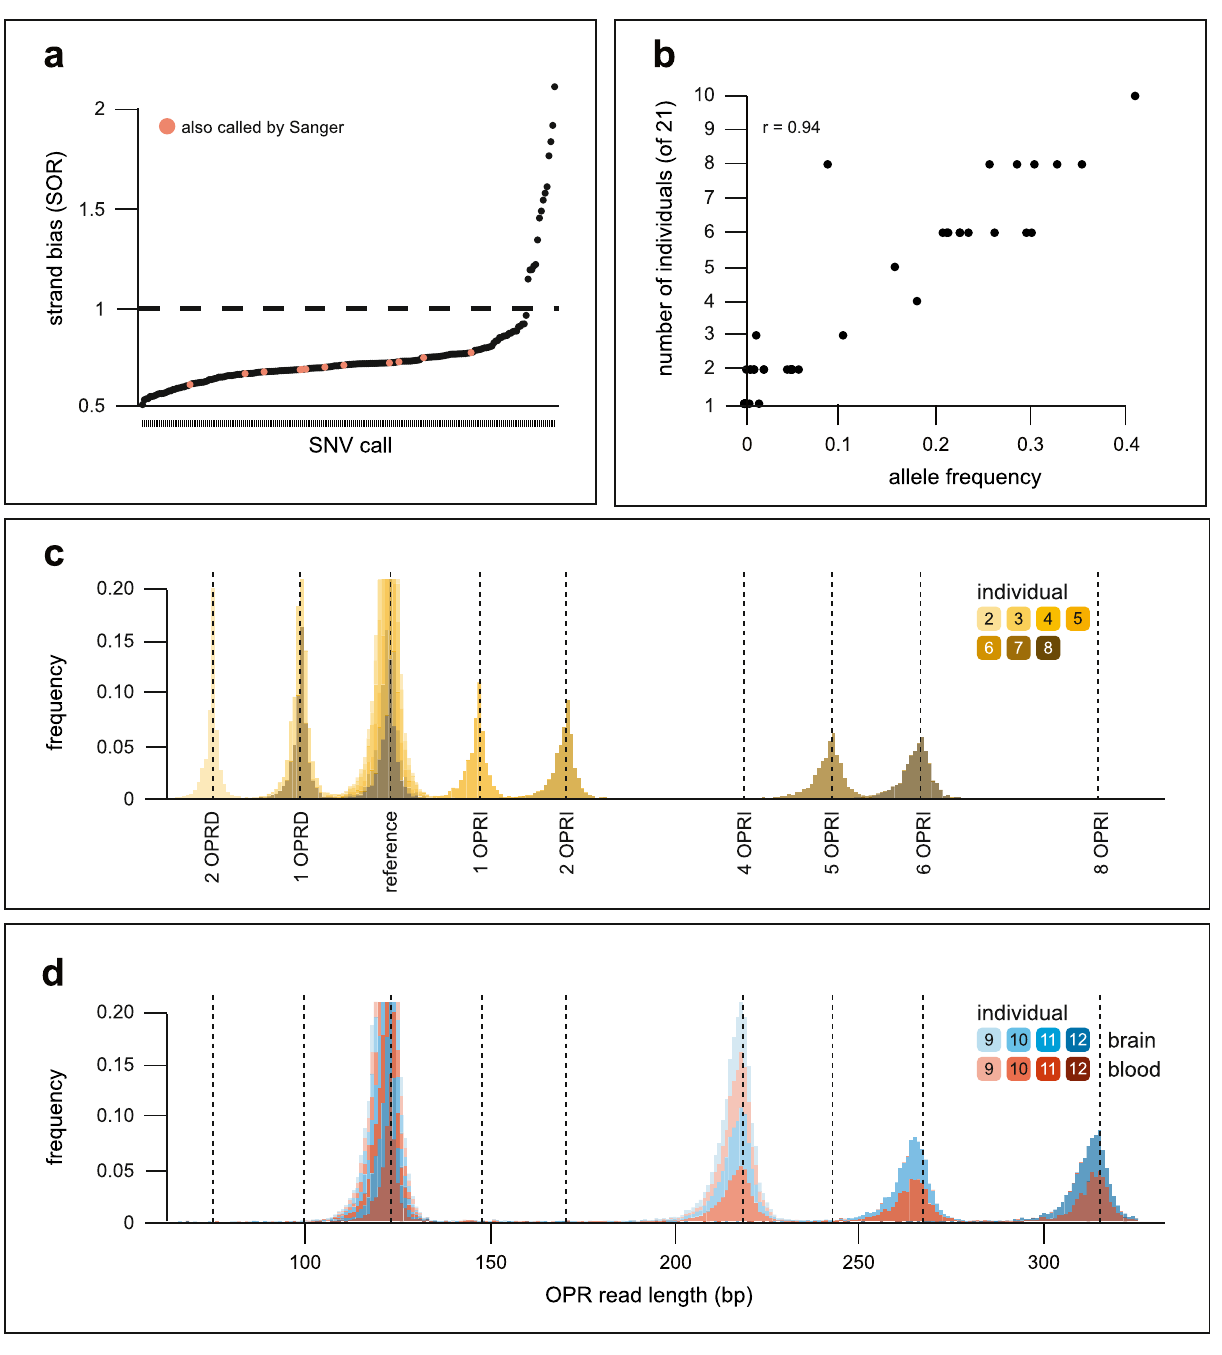
Figure 2. Detection of known variants in PRNP with Nanopore sequencing. ( a ) Each dot represents an SNV call by Nanopolish. SNV calls are ranked by increasing evidence of strand bias (SOR, strand odds ratio). In orange are the SNVs in the protein-coding region which were also called by Sanger. They are together the set of true positives we used to calibrate our strand bias threshold (SOR = 1.0, dashed black line). ( b ) Number of individuals from our panel who carried each unique SNV as a function of allele frequency in the general population. r = 0.94 by Pearson’s correlation. ( c ) Lengths of the OPR reads in seven inherited CJD cases. ( d ) Lengths of the OPR reads in four inherited cases for which genomic DNA from blood and brain was sequenced. The read lengths form a distribution around each expected OPR length due to small artefactual insertions/ deletions typical of Nanopore sequencing. See Table 1 for more details about individuals and